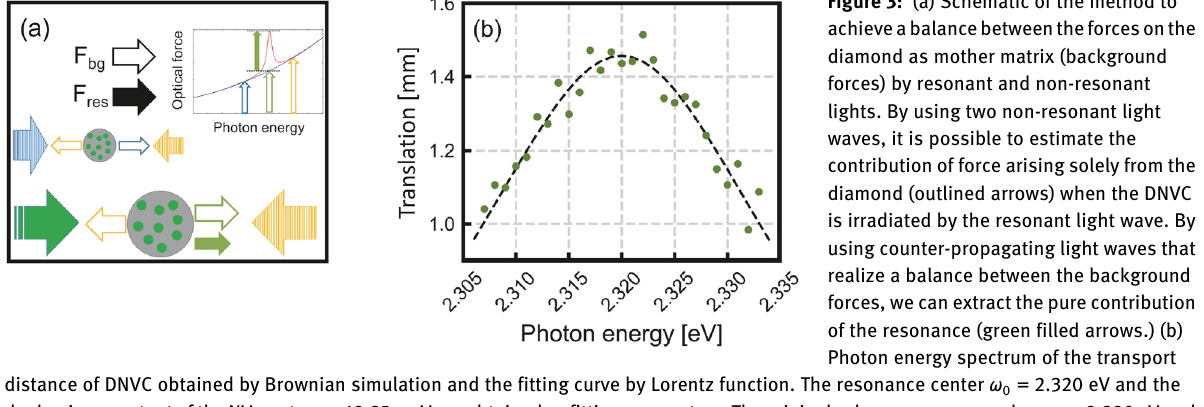
Figure 3: (a) Schematic of the method to achieveabalancebetweentheforcesonthe diamond as mother matrix (background forces) by resonant and non-resonant lights. By using two non-resonant light waves, it is possible to estimate the contribution of force arising solely from the diamond (outlined arrows) when the DNVC is irradiated by the resonant light wave. By using counter-propagating light waves that realize a balance between the background forces, we can extract the pure contribution of the resonance (green filled arrows.) (b) Photon energy spectrum of the